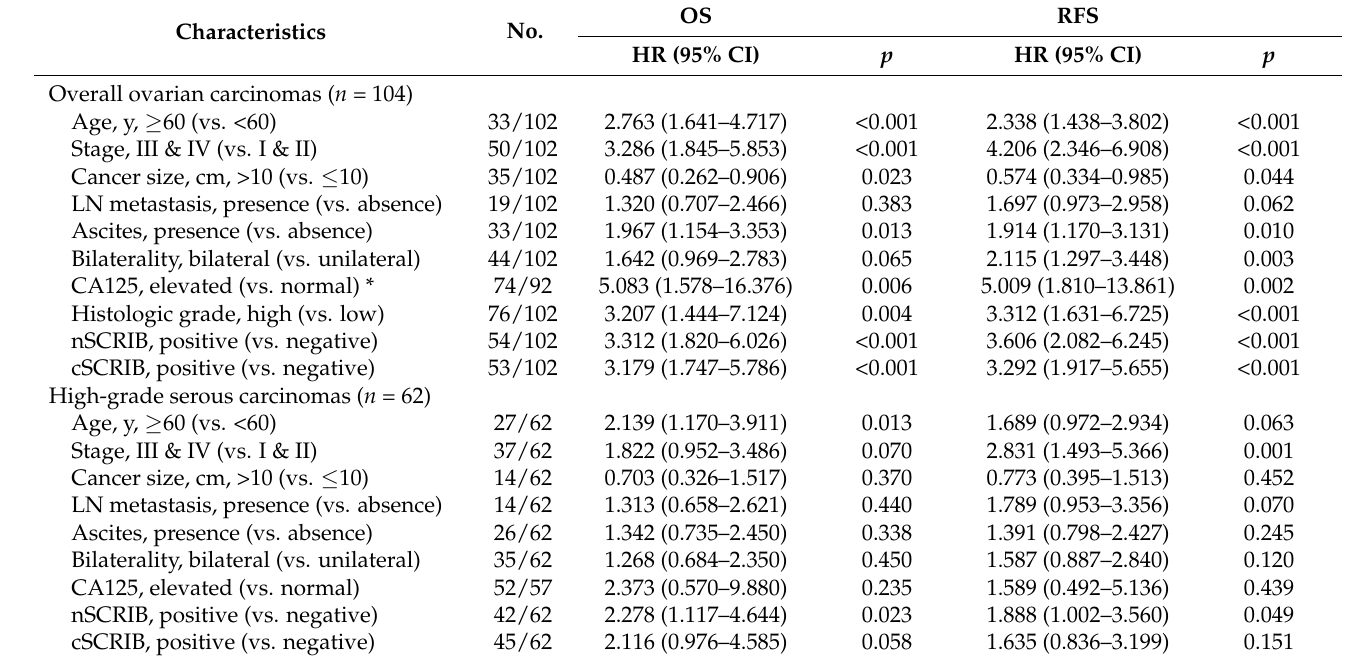
Table 3. Univariate analysis in overall ovarian carcinoma and 62 high-grade ovarian carcinomas.